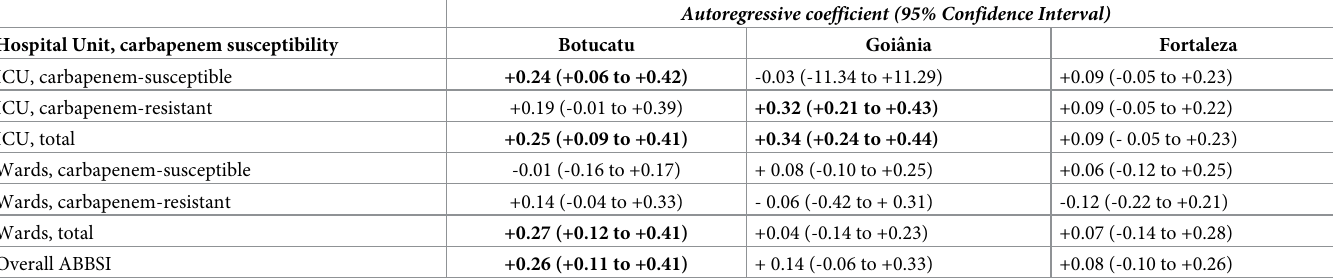
Table 3. Seasonal autoregressive coefficients from Box-Jenkins models for incidence of Acinetobacter baumannii complex bloodstream infections, according to type of hospital unit and